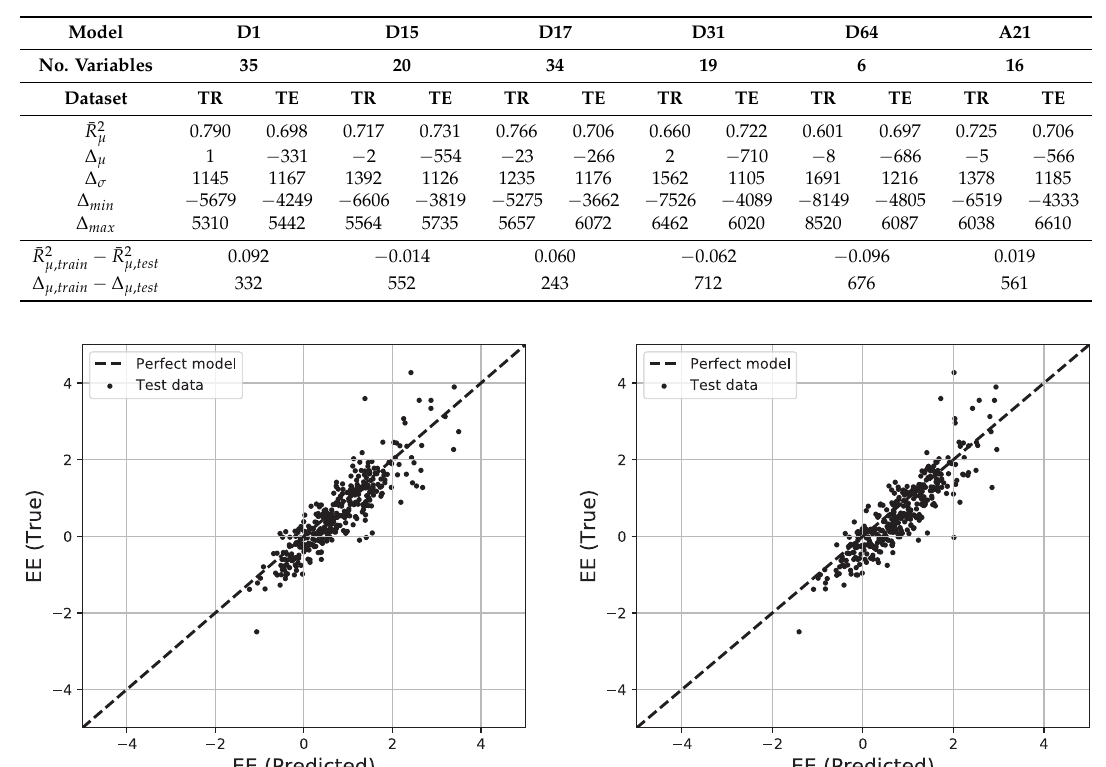
Table 10. Performance of the selected models on the training and test data. Models called D are from the Domain approach and models called A are from the algorithmic approach. TR and TE are short for training and test, respectively.